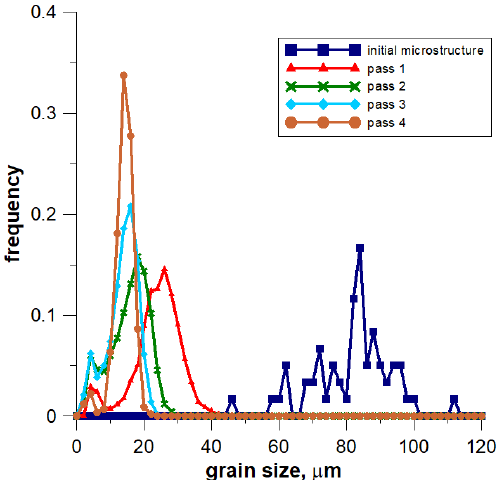
Figure 22. Grain size distribution for the modeled passes of the flat rolling process.